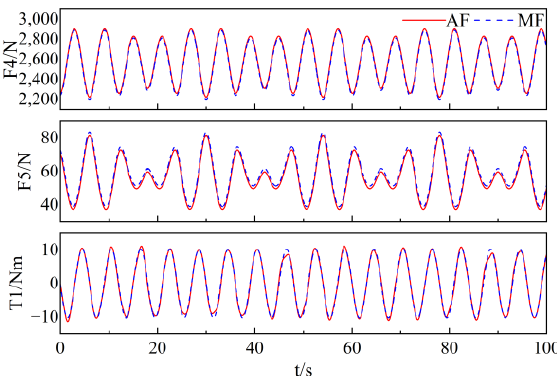
Figure 13. Tractive force or driving torque of each joint of the transfer gangway under the dynamic load.